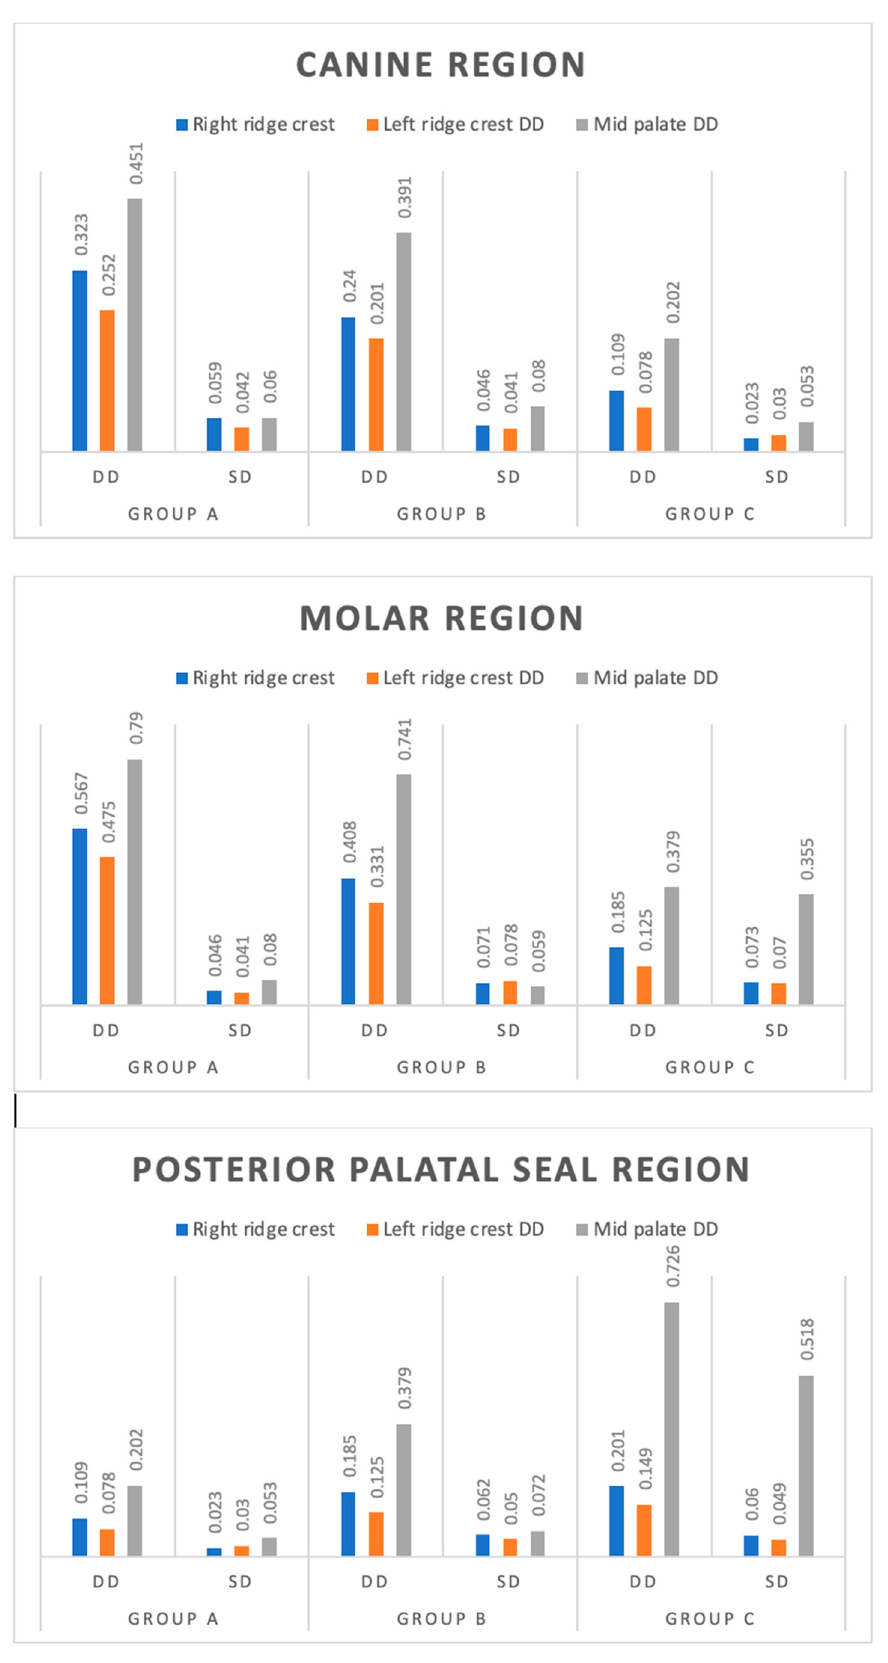
Figure 8. Mean dimensional discrepancy (mm) of three groups at three sites of canine, Molar and Posterior Palatal region at 24 h. Dimensional discrepancy (DD); Standard deviation (SD).